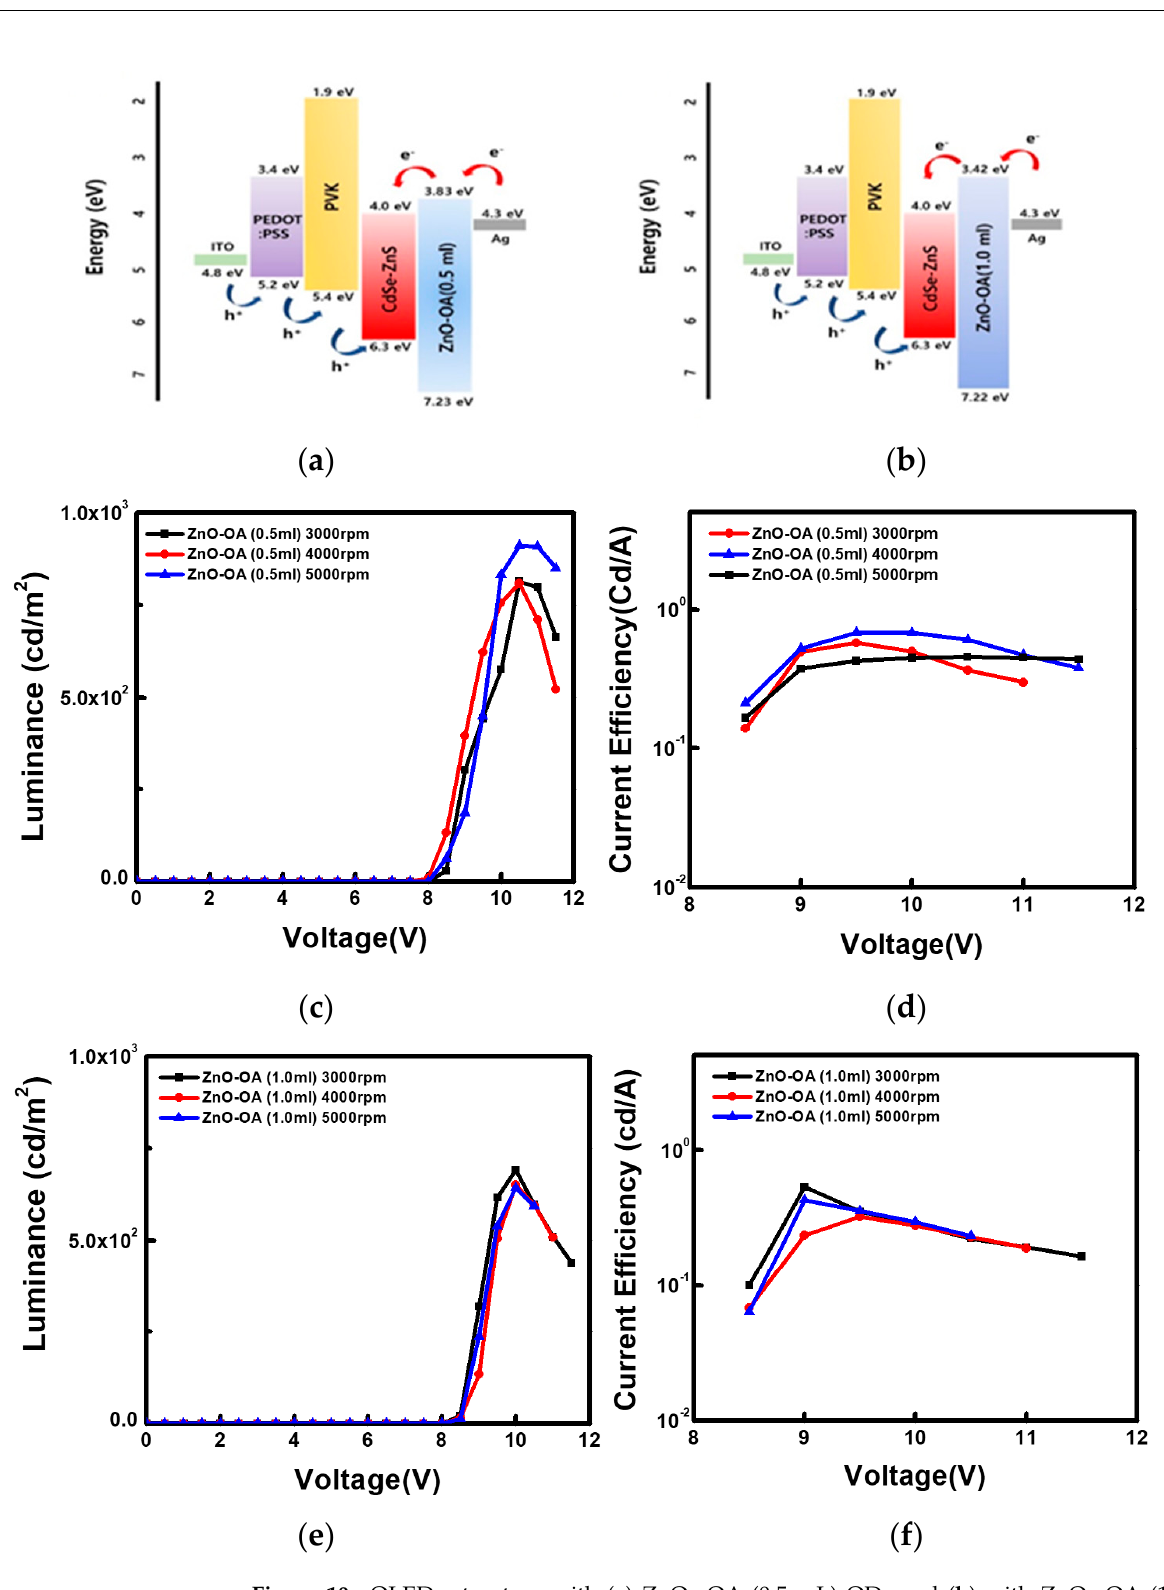
Figure 10. QLEDs structure with ( a ) ZnO − OA (0.5 mL) QDs and ( b ) with ZnO − OA (1.0 mL) QDs ETL. ( c ) Luminance − voltage curves and ( d ) current efficiency − voltage curves of QLEDs with different thicknesses of ZnO − OA (0.5 mL) QDs ETL. ( e ) Luminance − voltage curves and ( f ) current efficiency − voltage curves of QLEDs with different thicknesses of ZnO − OA (1.0 mL) QDs ETL.